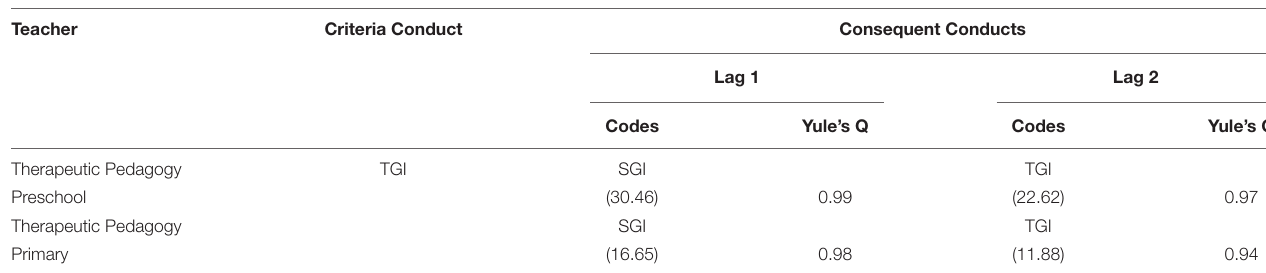
TABLE 13 | Interaction